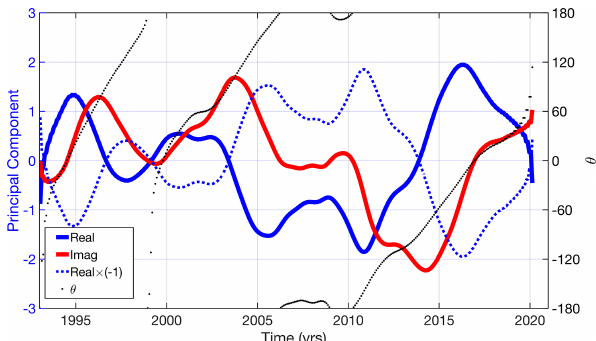
Figure 9. Time evolution of the CEOF 1 mode: (solid blue curve) real and (red curve) imaginary components, (dashed blue curve) real part of CPC 1 rotated by 180 ◦ , and (dotted black curve) the temporal phase of the